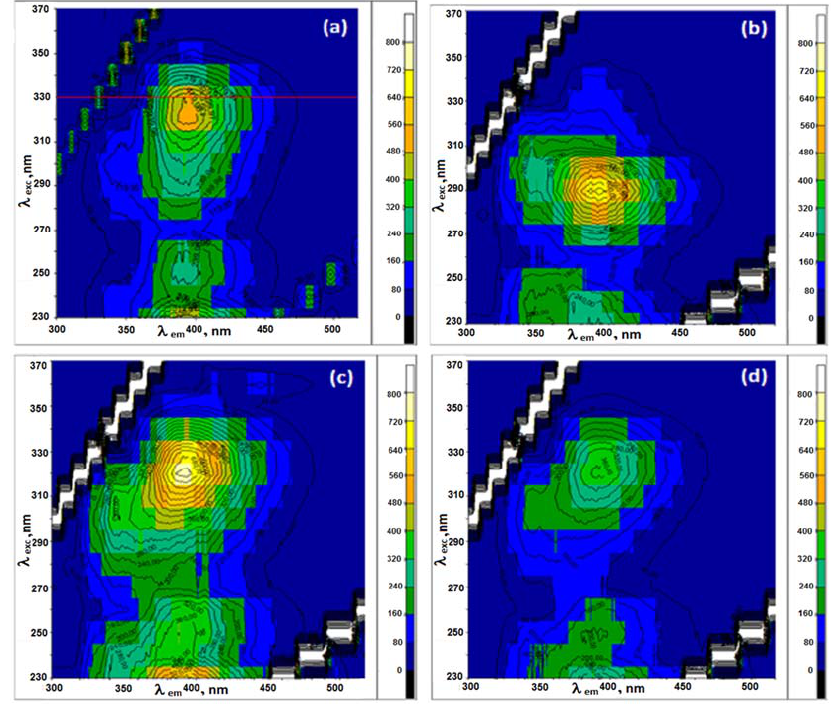
Figure 1. Three-dimensional (3D) fluorescence contour maps of ( a ) pyridoxine (0.8 mg L − 1 ) in aqueous solution (pH = 5.9), ( b ) 10 mM Brij L23 in aqueous solution (pH = 3.4), ( c ) 10 mM Brij L23 in phosphate buffer (pH = 7.0), and ( d ) 1 wt % G dispersion in 10 mM Brij L23 in buffer (pH = 7.0).